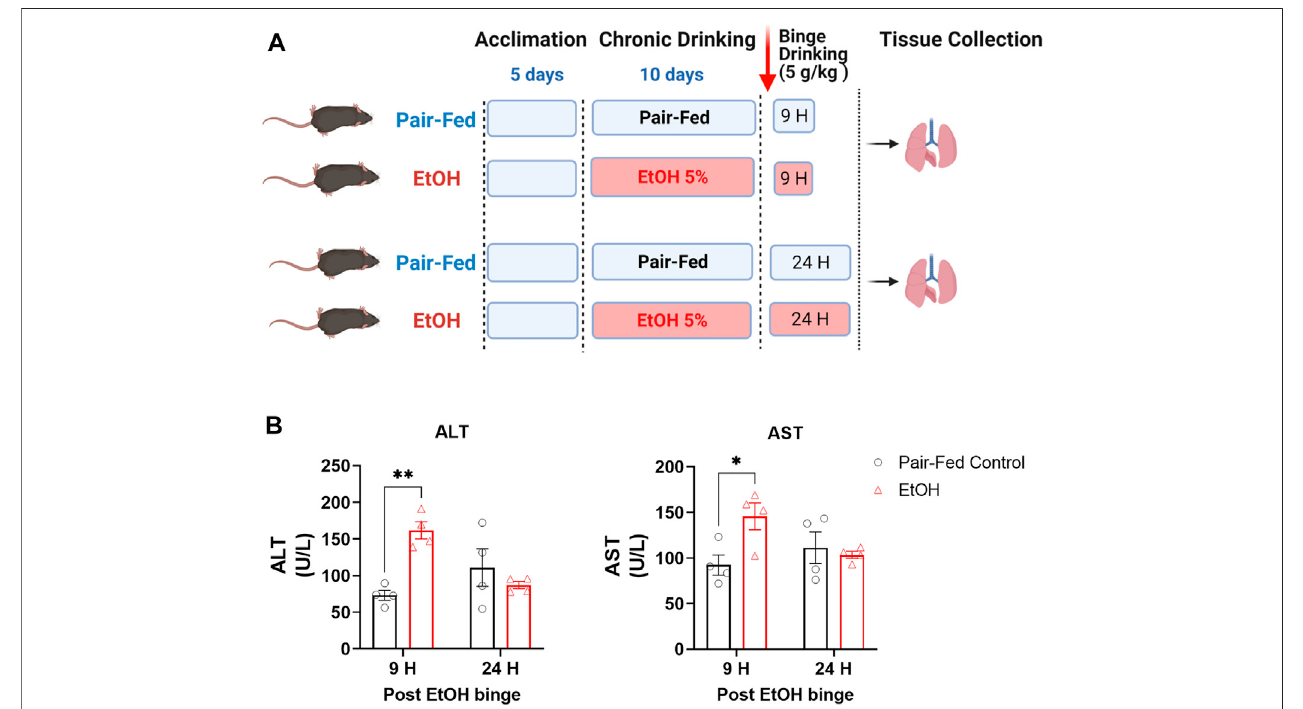
FIGURE 1 | Experimental paradigm of the NIAAA alcohol feeding model in mice. (A) Schematic presentation of the NIAAA alcohol feeding model. (B) Levels of alanine transaminase (ALT) and aspartate transaminase (AST) in serum. Data represent mean +S.E.M from 4 mice per group. Data were analyzed by one-way ANOVA followed by Dunnett ’ s multiple comparisons test. * ( p < 0.05), ** ( p < 0.01) indicates signi fi cant difference from the pair-fed control